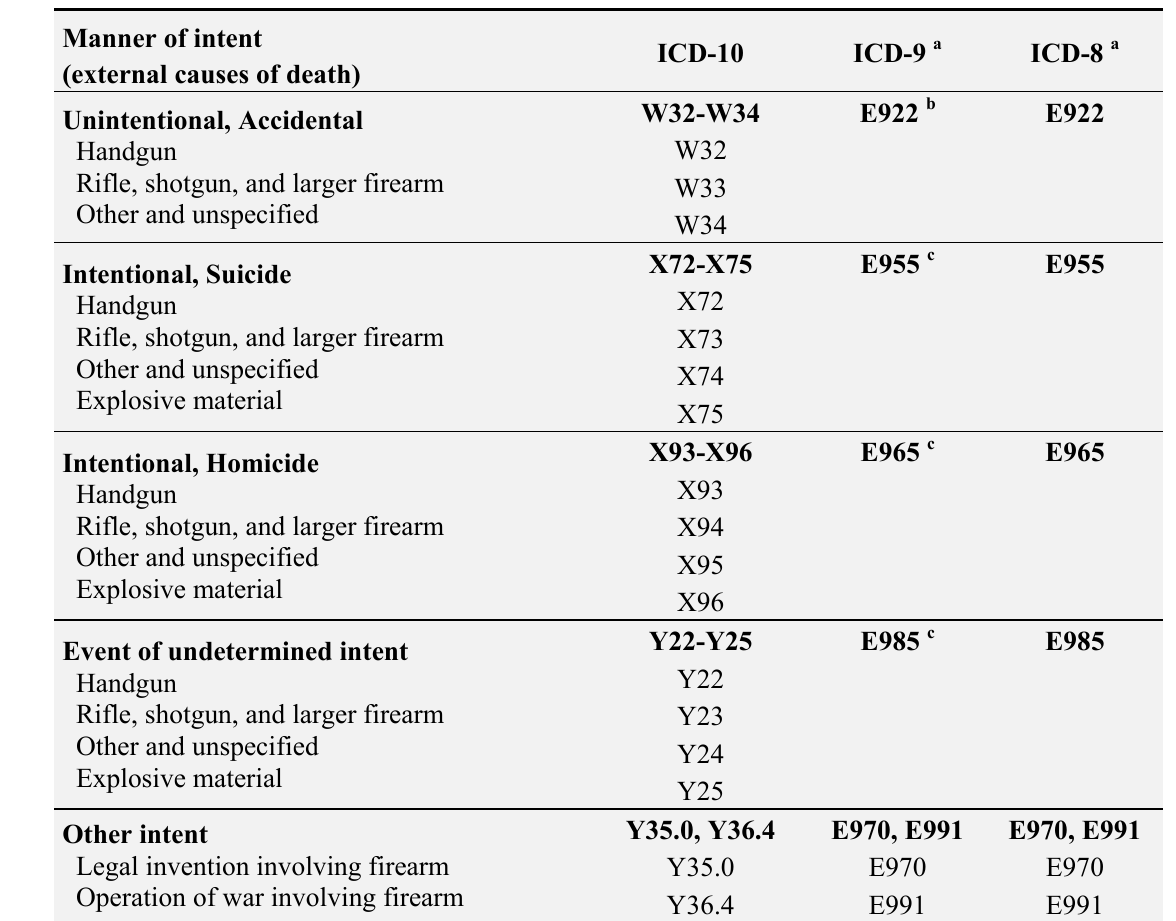
Table 1. Matrix for firearm